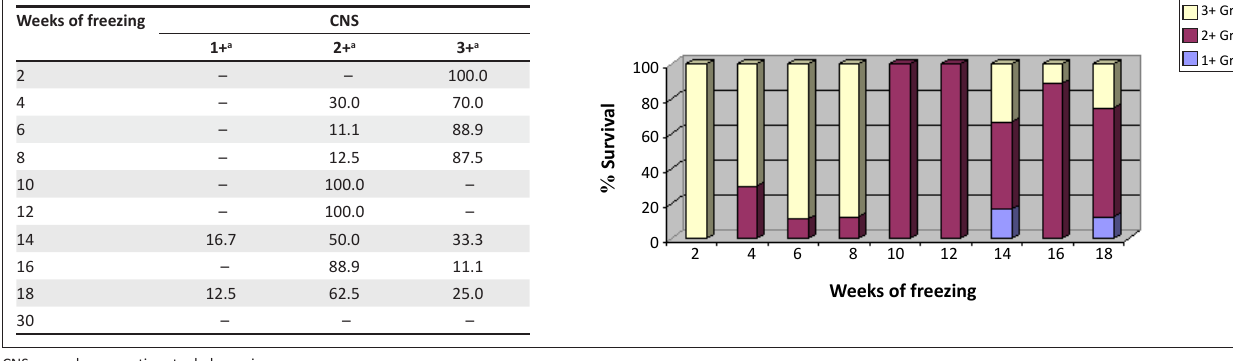
Weeks of freezing